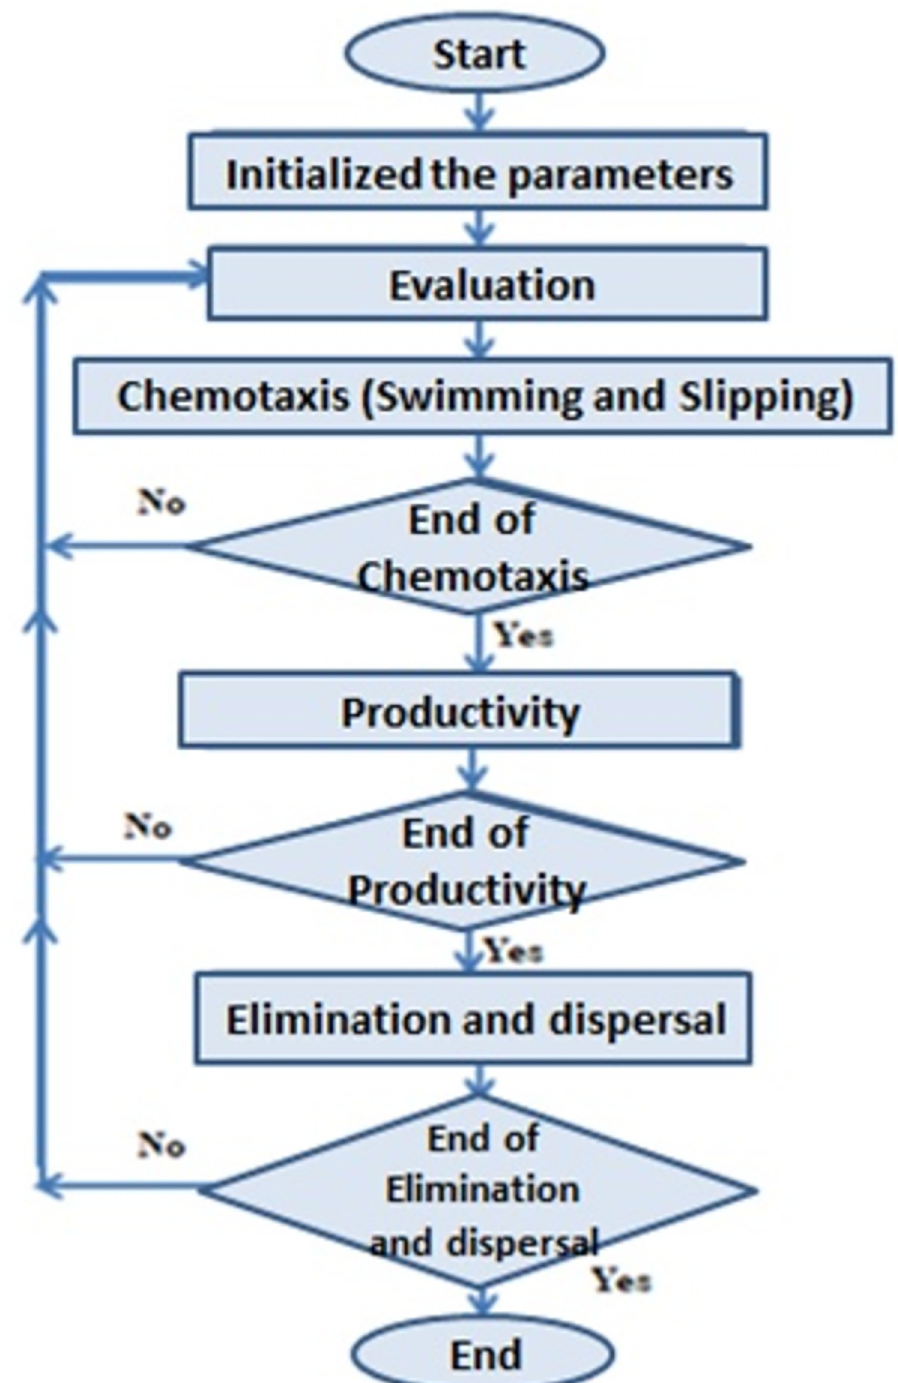
Fig 1. The flowchart of the